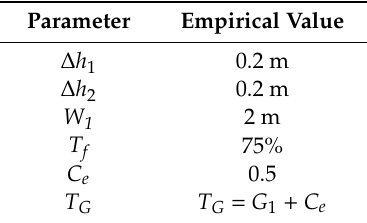
Table 1. The empirical values of parameters for identifying the segmentation positions and key segmentation